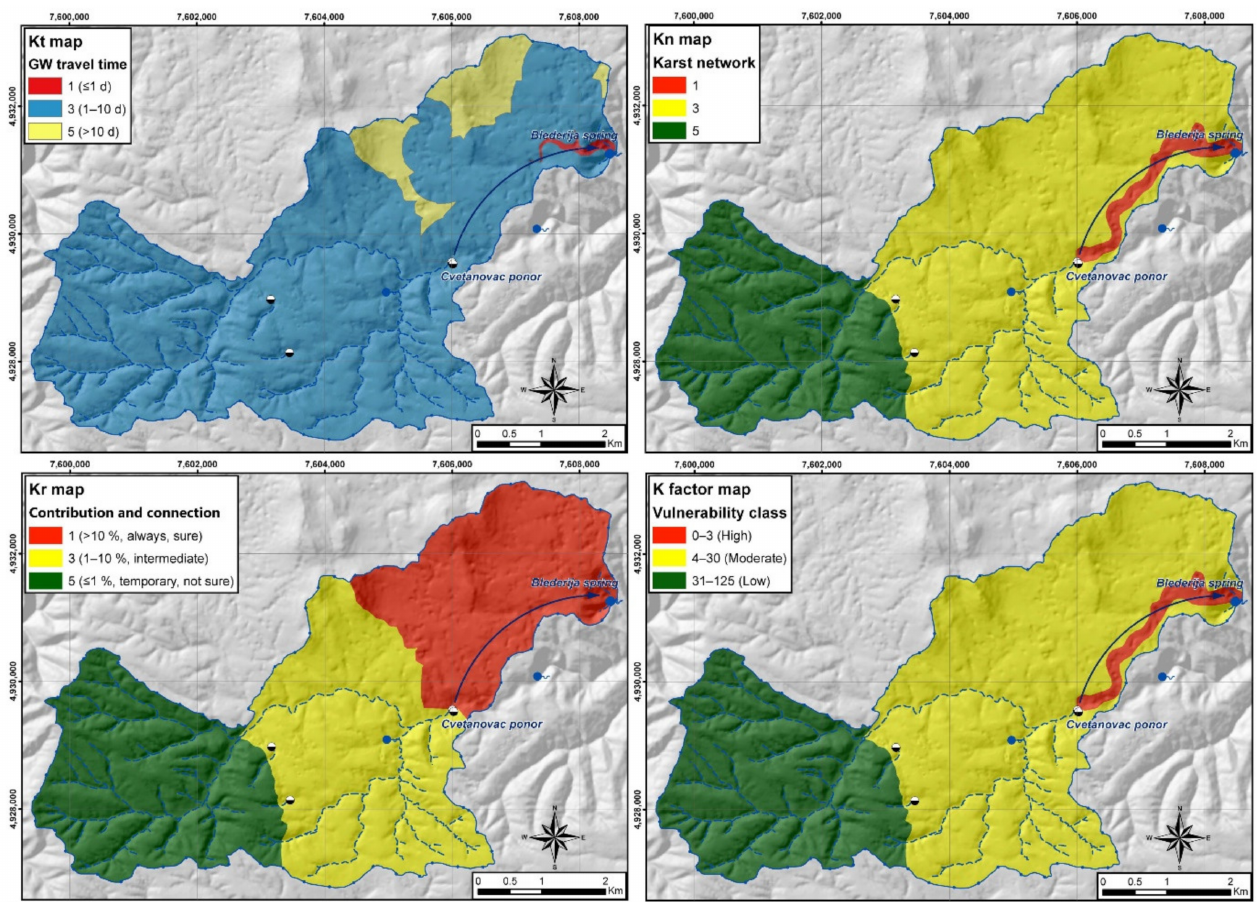
Figure 4. K factor map for source groundwater